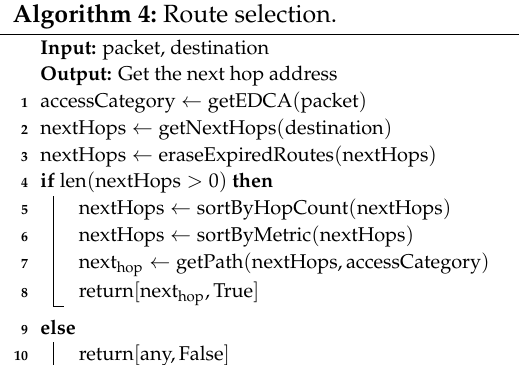
Algorithm 4: Route